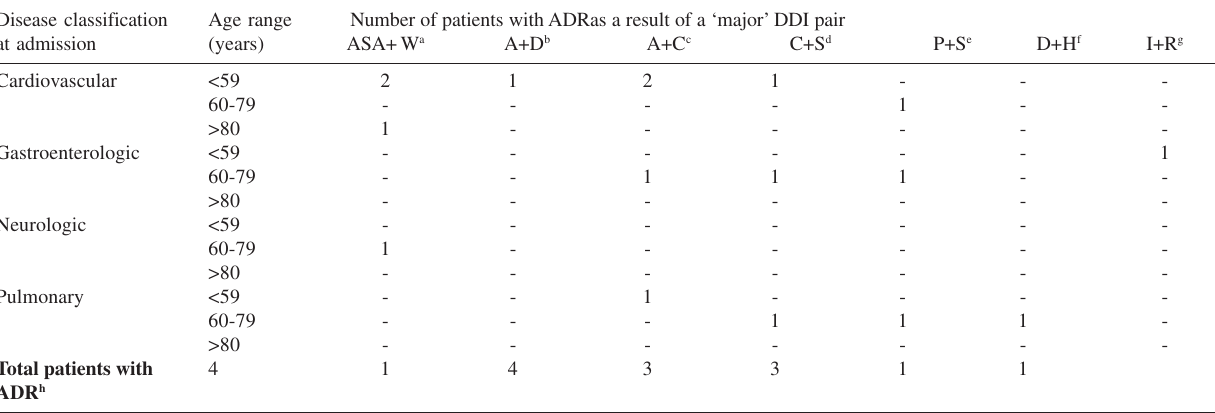
Table 1 - Number of patients whose prescriptions had a ‘major’ drug-drug interaction (DDI) and whose records showed signs and symptoms of adverse drug reactions (ADR), by disease classification and age Disease